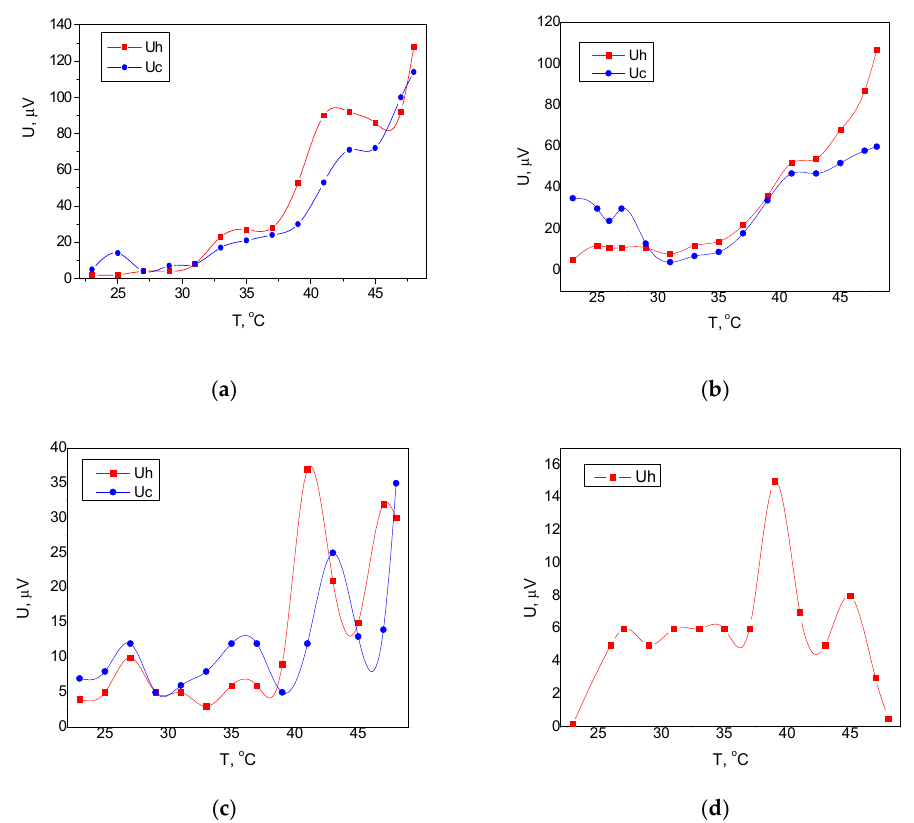
Figure 4. Pyroelectric response of silicon/Al/BST/PVDF-TrFE/ devices with ( a ) in-plain design; ( b ) out-of-plain design; ( c ) single layer coating of ferroelectric oxide with in-plain electrodes; ( d ) single layer coating of pyroelectric ink with out-of-plain electrodes. U h —the measured voltage at the sample heating; U c —the measured voltage at the sample cooling.